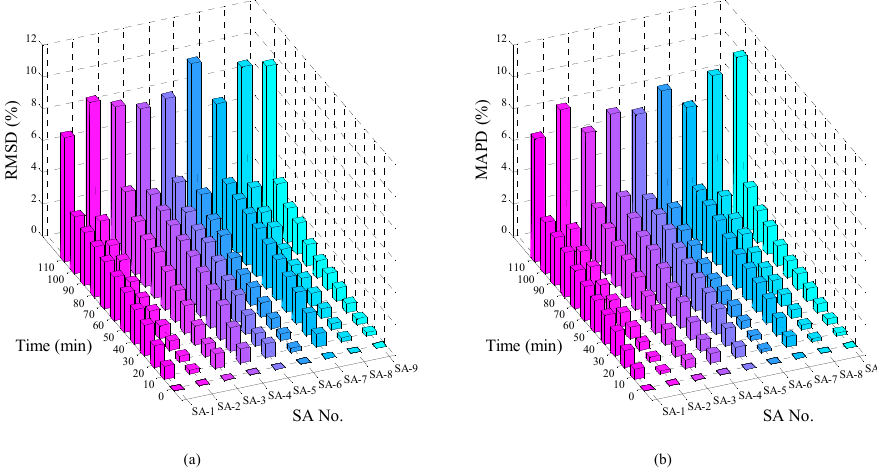
Figure 11. The damage matrices of the conductance for the nine SAs during the test. ( a ) RMSD, ( b ) MAPD.